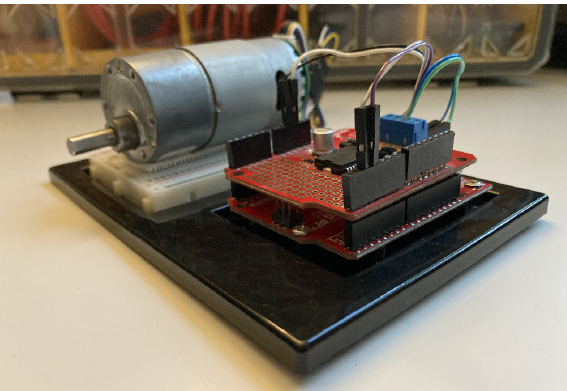
Figure 17. The target system as a velocity control in a real-time